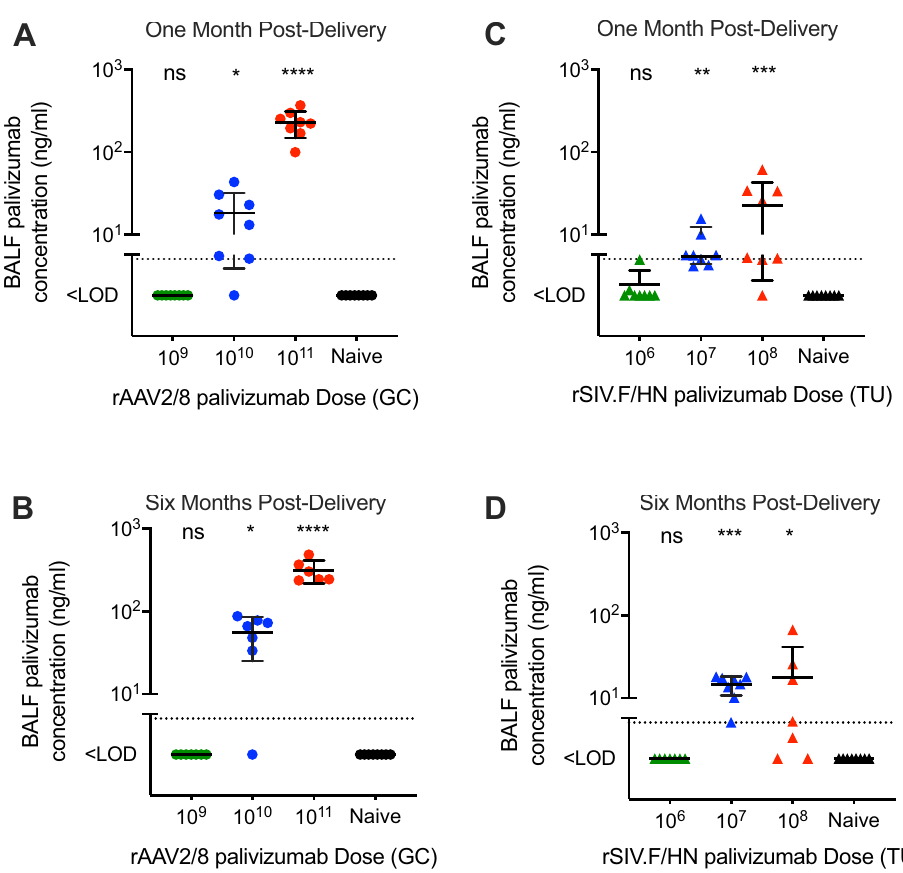
Figure 4. In vivo production of palivizumab from rAAV2/8 and rSIV.F/HN: BALF. Female BALB/c mice (n = 16/group) were administered 10 9 (green circles), 10 10 (blue circles) or 10 11 (red circles) Genome Copies (GC) of rAAV2/8 CASI Glux via intramuscular (IM) injection; 10 6 (green triangles), 10 7 (blue triangles) or 10 8 (red triangles) Transducing Units (TU) of rSIV.F/HN hCEF palivizumab via intranasal (IN) instillation, or were naïve to treatment. Animals treated with ( A and B ) rAAV2/8 or ( C and D ) rSIV.F/HN were culled at either 1 month ( A and C ) (n = 8/group), or 6 months ( B and D ) (n = 6–8 group) post-delivery to obtain BALF. Palivizumab levels in the BALF was measured using a Human IgG ELISA. The dotted line represents the LOD. Differences between treatment groups and naïve animals were evaluated using the Kruskal–Wallis test with Dunn’s post hoc multiple comparison